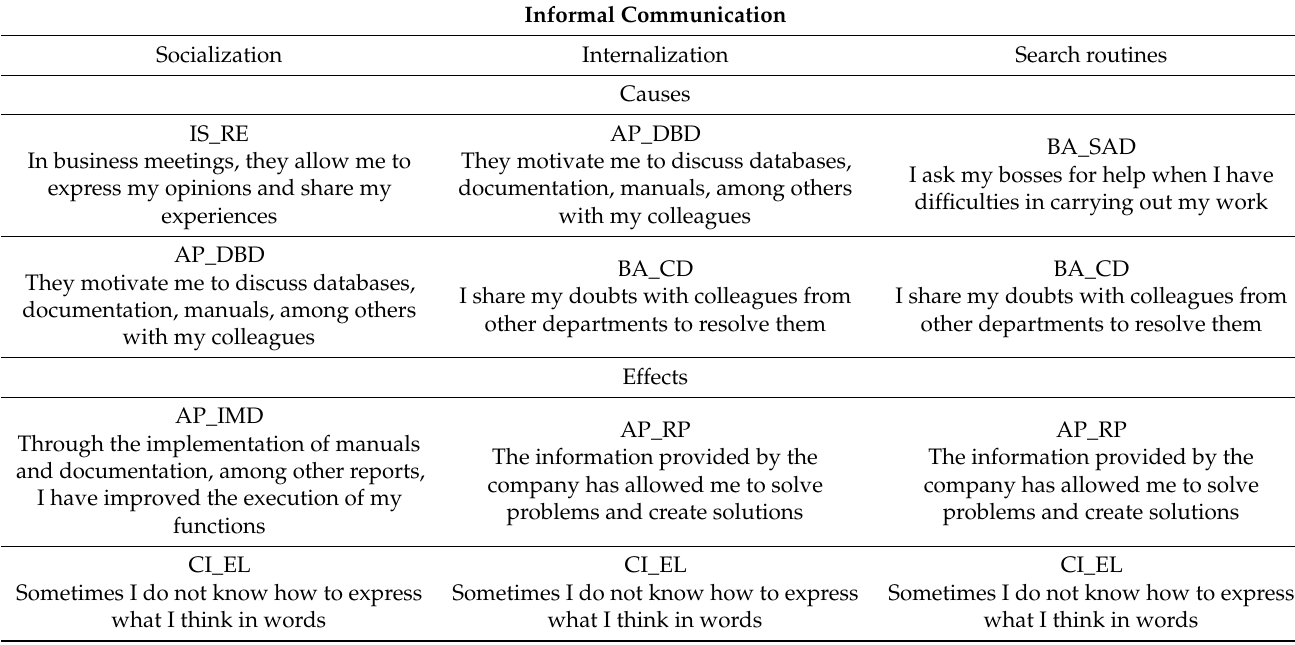
Table 12. Alternate routes of informal communication.